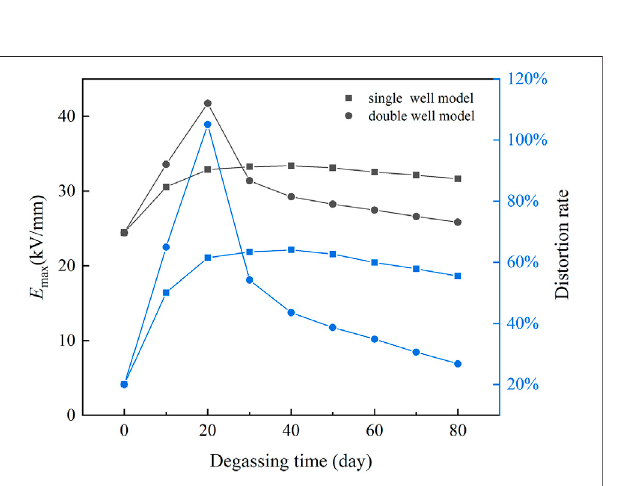
Frontiers in Chemistry |